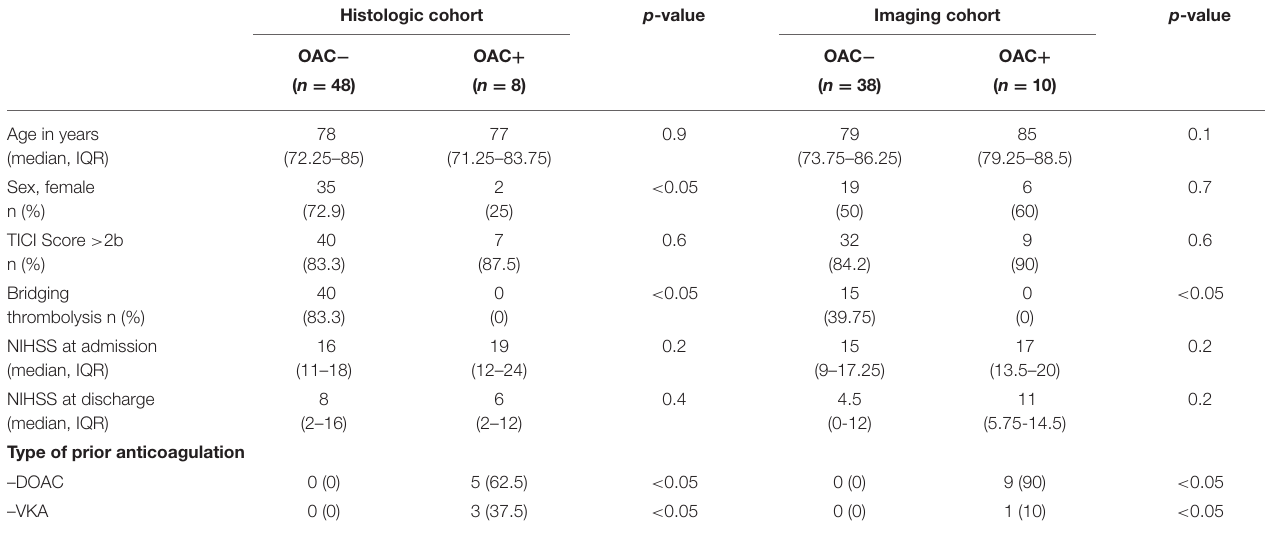
TABLE 1 | Baseline characteristics of patients with suspected cardioembolic stroke in respect of prior anticoagulation for the histologic and imaging cohort. Histologic cohort p -value Imaging cohort